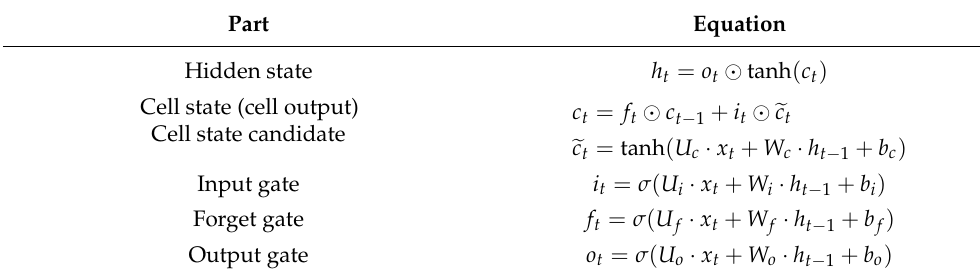
Table 4. Governance equations of an LSTM cell.